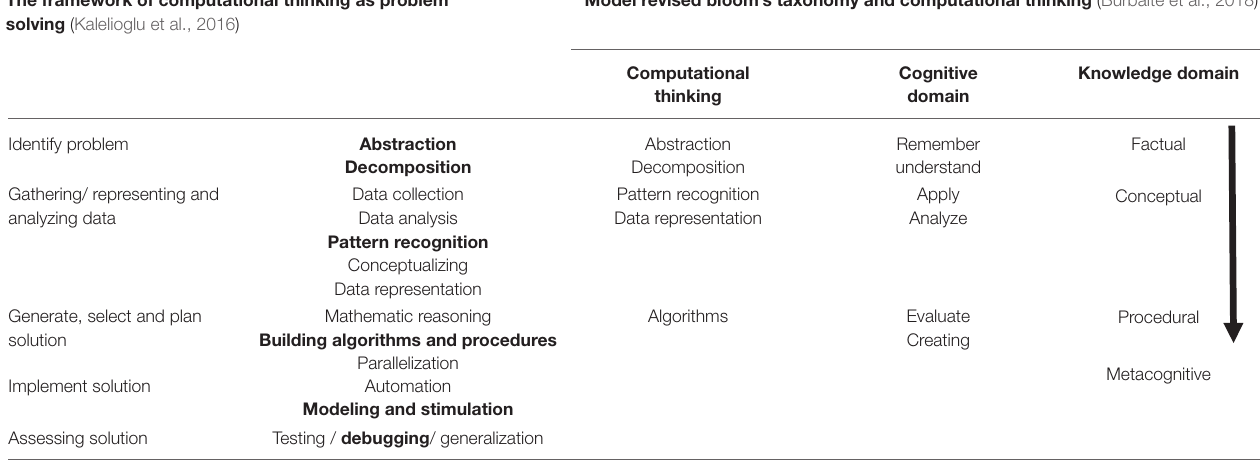
Model revised bloom’s taxonomy and computational thinking (Burbaite et al.,